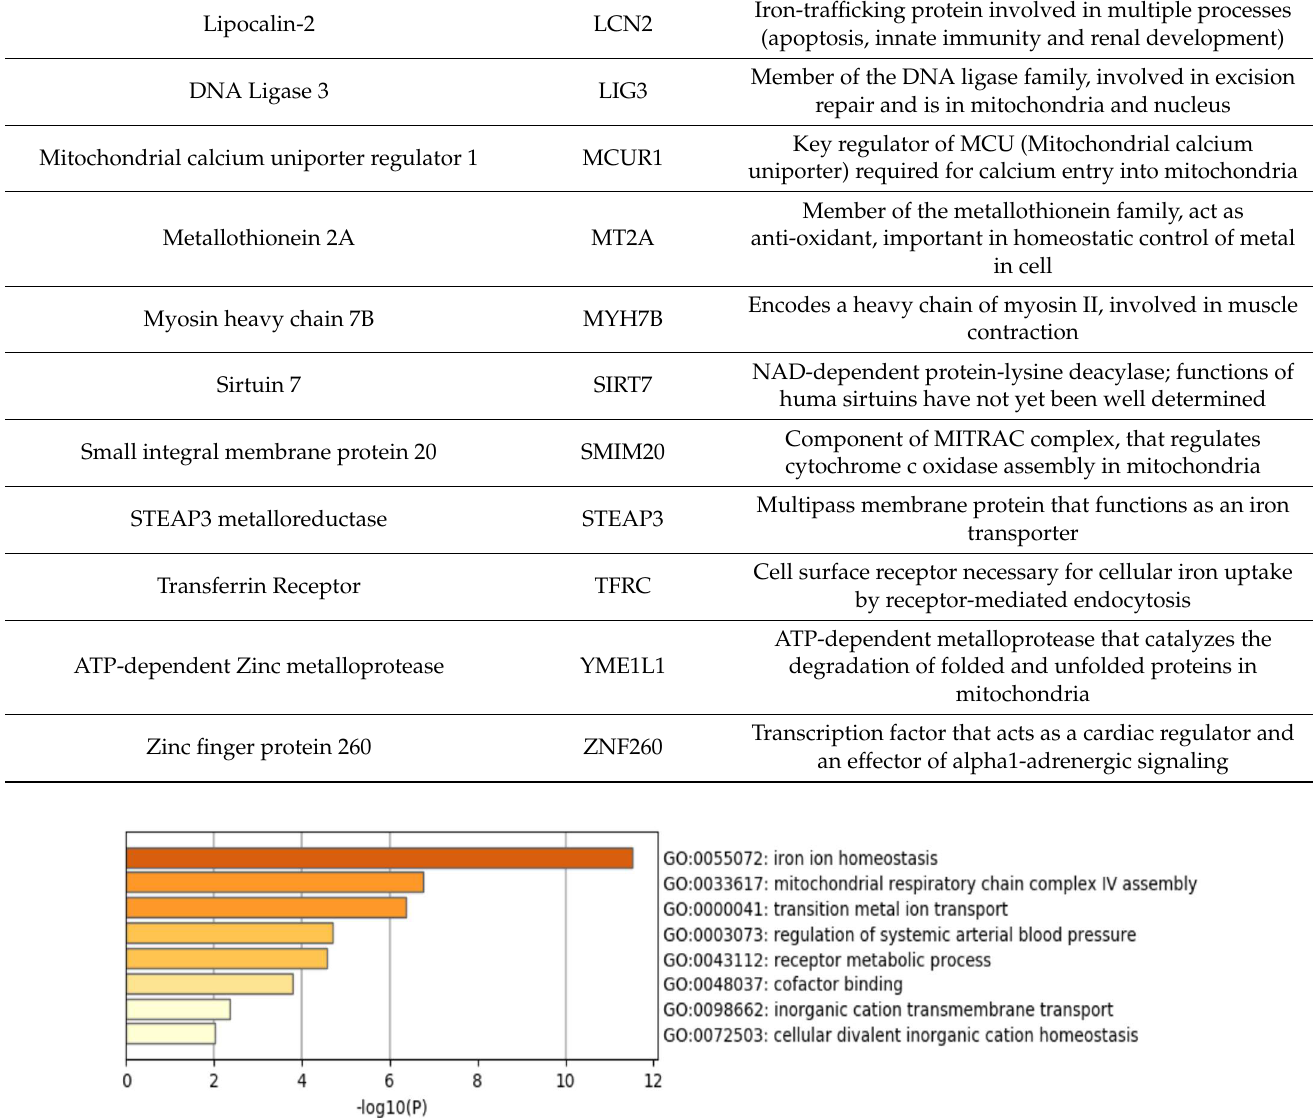
Figure 1. Enriched gene ontology (GO) terms of the 22 candidate genes evaluated in cohort #2. Analysis was carried out by Metascape. The x-axis denotes − log10 ( p ) values based on the cumulative hypergeometric distributions. The colors denote de relative value of − log10 ( p ): darker colors indicate a greater value of − log10 ( p ).